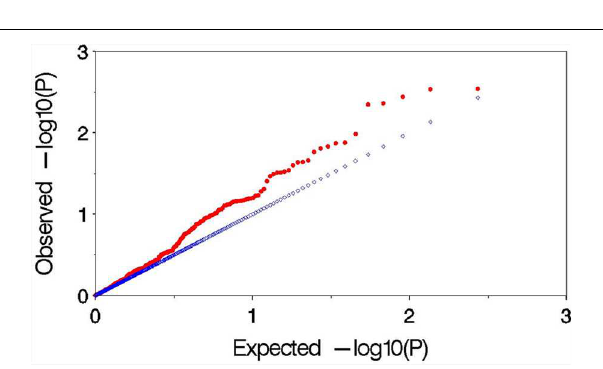
FIGURE 4 | Plot of observed versus expected P values by using MLM (Q + K) model for the association mapping for aluminum tolerance. The blue and red symbols are representing the expected P values and observed P values,